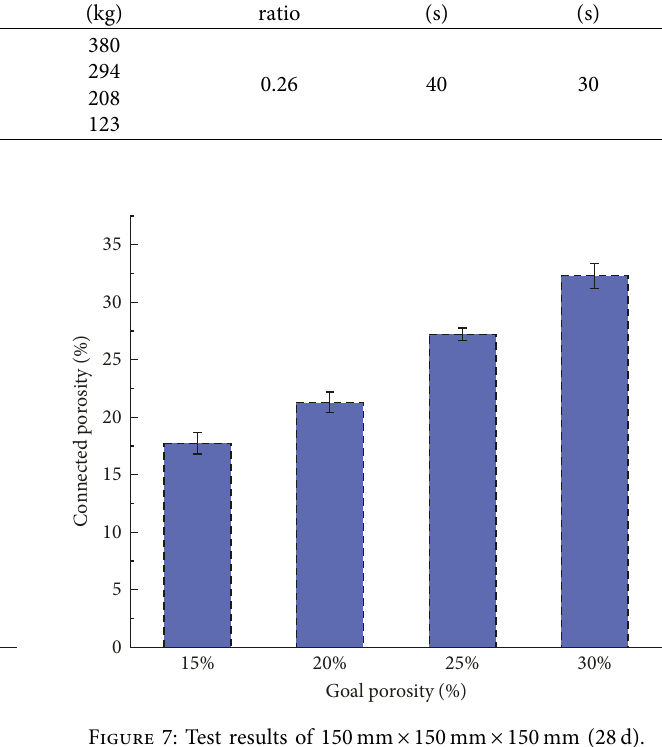
150mm 150mm (28d). × ×